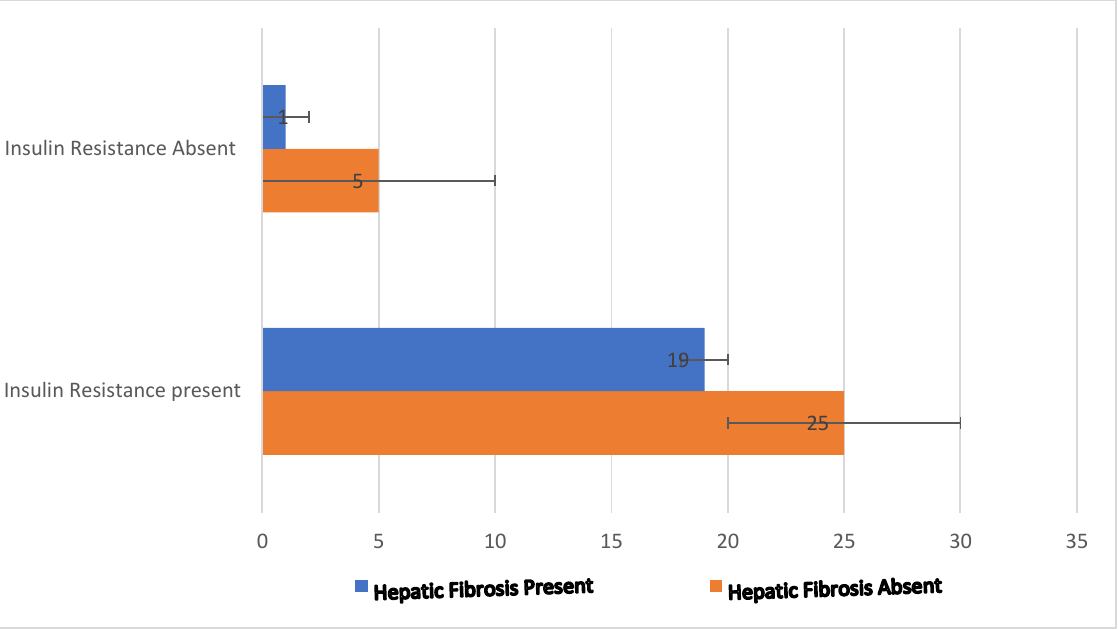
Figure 1. Showing the presence of insulin resistance among patients with hepatic